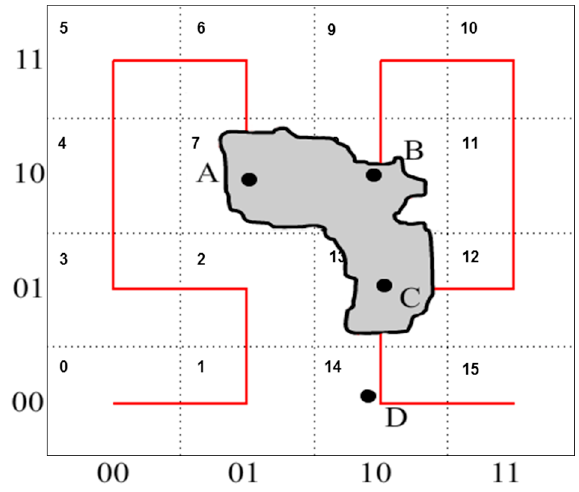
Figure 2. An example that shows the data collection path of all group heads.